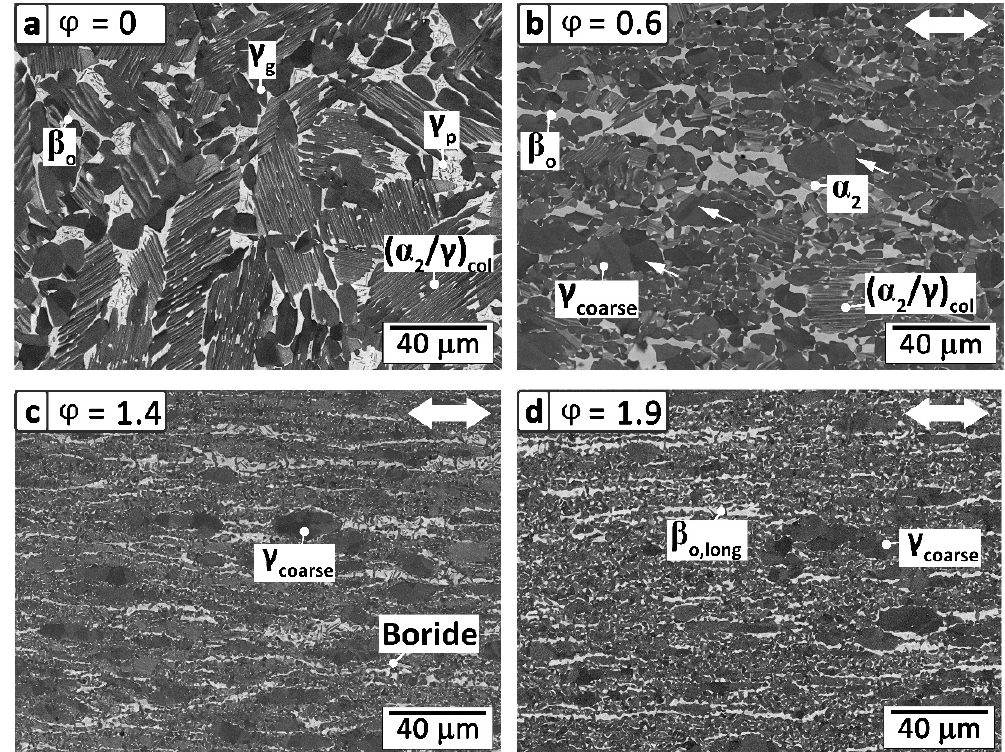
Figure 1. SEM micrographs recorded in backscattered electron (BSE) mode of the microstructures of the different specimens investigated within this work. All specimens were heat treated to enable static recrystallization as well as to provide a thermally stable microstructure. ( a ) Cast/hot isostatic pressed (HIPed) and heat treated (HT) microstructure containing ( α 2 / γ ) col , γ g , and surrounding β o -phase; ( b ) the ϕ = 0.6 deformed specimen with partly recrystallized ( α 2 / γ ) col , as well as fine γ and α 2 grains. The arrows indicate twins within the γ g grains; ( c ) illustrates the microstructure of the ϕ = 1.4; and ( d ) the ϕ = 1.9 deformed samples. The latter two exhibit a similar appearance and an almost completely recrystallized microstructure. Solely isolated γ coarse -grains and the elongated β o -phase constitute deviations from the homogenous microstructure. The extrusion direction is indicated by white arrows in the right upper corner of the SEM images.